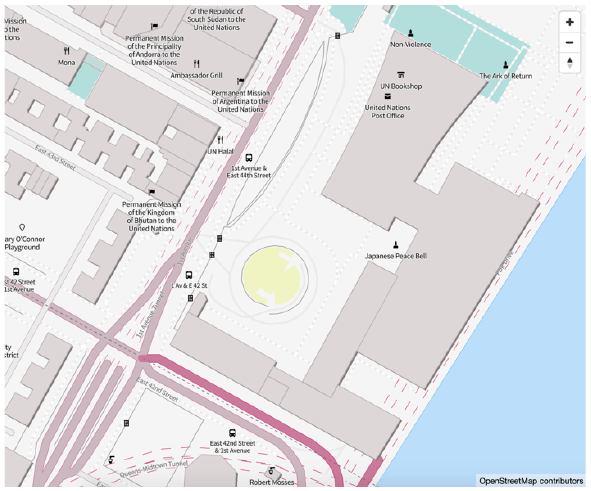
Figure 4. Produced Vector Tiles rendered on a Browser